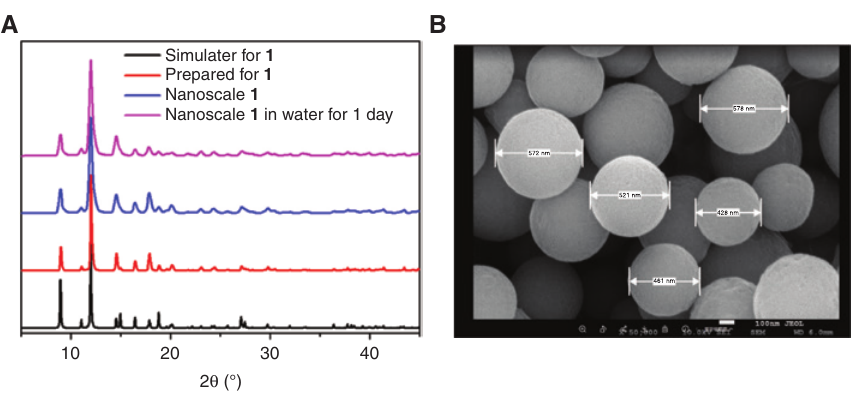
Figure 3: The PXRD patterns and SEM image for 1 . (A) The PXRD patterns for 1 and (B) the SEM image of sphere morphology for the nanoscale 1